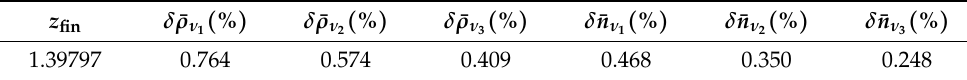
Table 5. Neutrino number density per one degree of freedom in the current homogeneous and isotropic universe including non-thermal distortions due to e ± -annihilation during neutrino decou- pling.